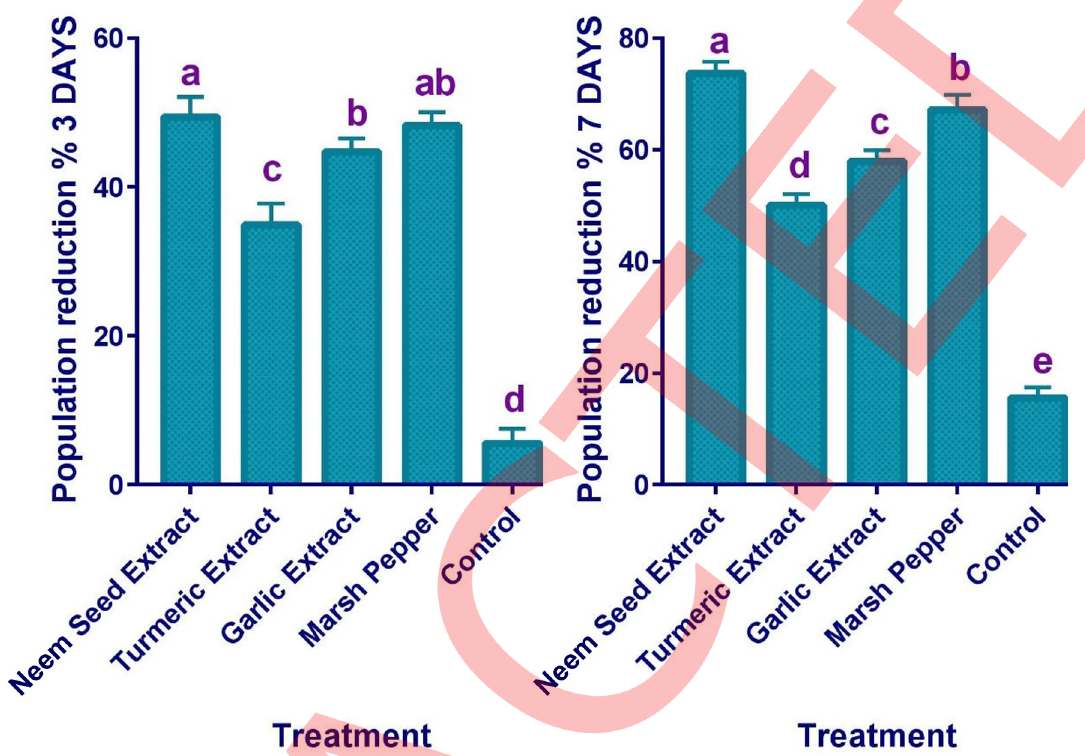
Fig 3. Population reduction percentage of H . armigera larve in second round of spray at 3 and 7 days after treatment (DAT) on tomato plants treated with foliar application of various plant extracts. The values are means ± SD (n = 3). Different lower-case letters on bars indicate significant differences among treatments at P <